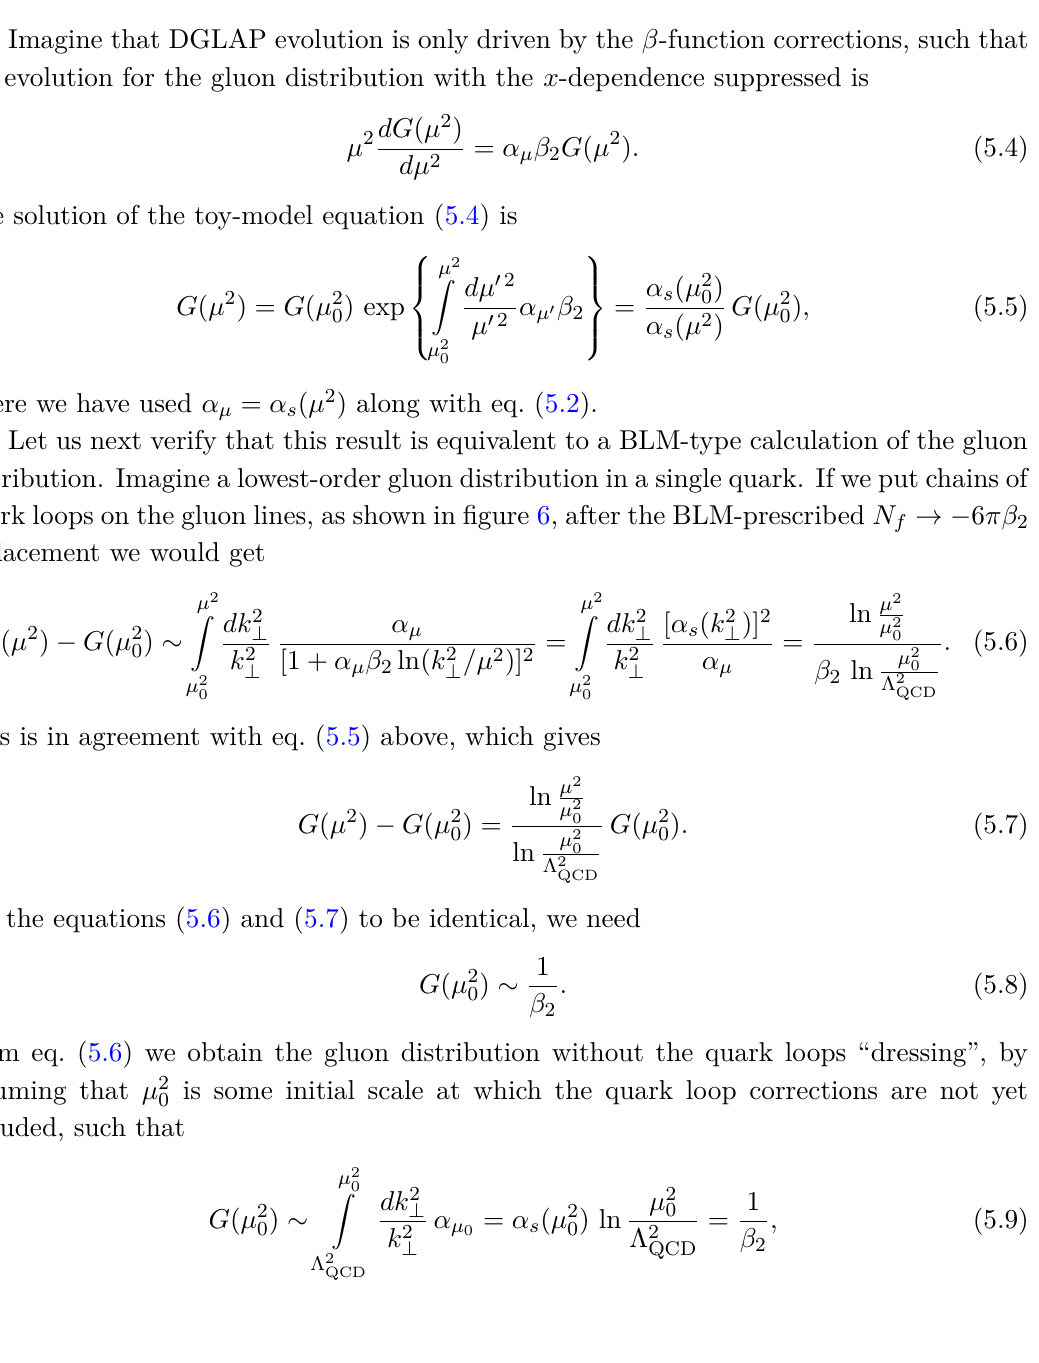
Figure 6 . Running coupling corrections to the leading-order gluon distribution in a single